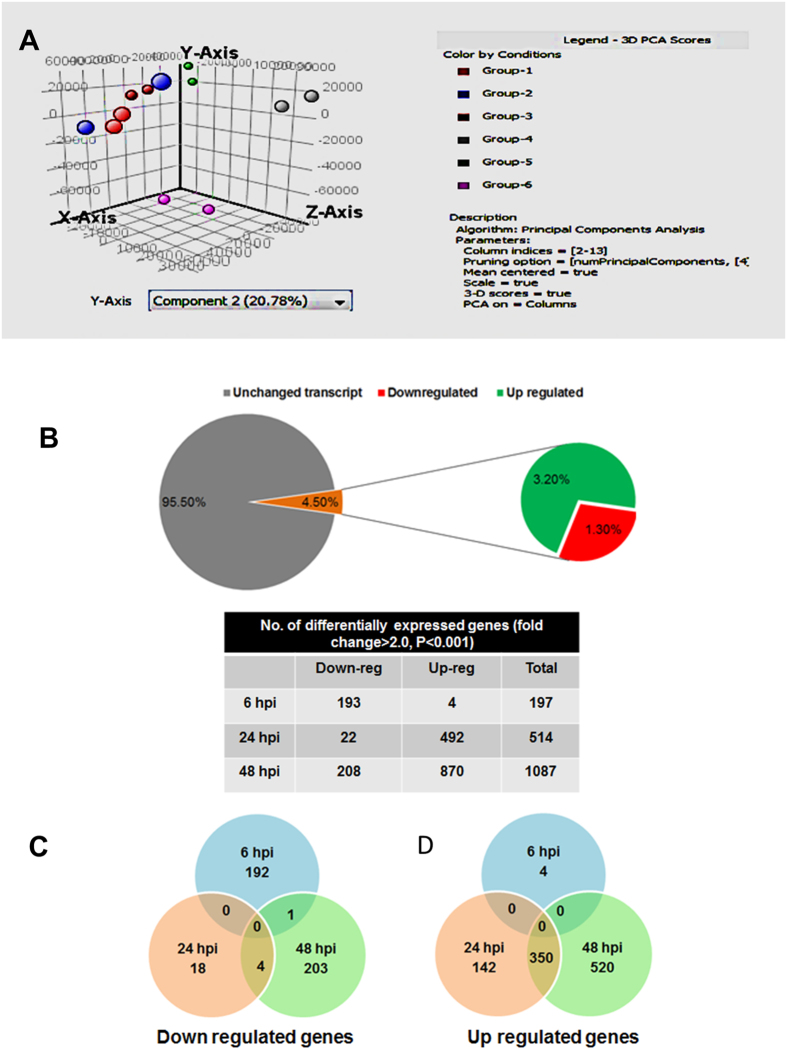
JEV infection in human microglial cells causes changes in cellular genes expression.(A) Principal Component Analysis (PCA) of microarray data. The blue, red pink, green, grey, purple circle dots represent liner combination of expression data including relative expression value and variance genes from control and infected duplicate sets of three different time points. (Group -1 = Control 6 h; Group-2 = JEV infected 6 h pi; Group-3 = Control 24 h, Group-4 = JEV infected 24 h pi; Group-5 = control 48 h, Group -6 = JEV infected 48 h pi) (B) Using one-way ANOVA, a total of 1434 genes exhibited reproducible change (P < 0.05). This represented 4.5% of the total 32000 transcript on the Affymetrix gene chip. About two-third of deregulated genes were upregulated and rest were downregulated. Table showing the number of deregulated genes expressed following JEV infection at 6, 24 and 48 h pi. (C) Venn diagram showing the overlap of differentially expressed (upregulated or down regulated) genes following virus infection.